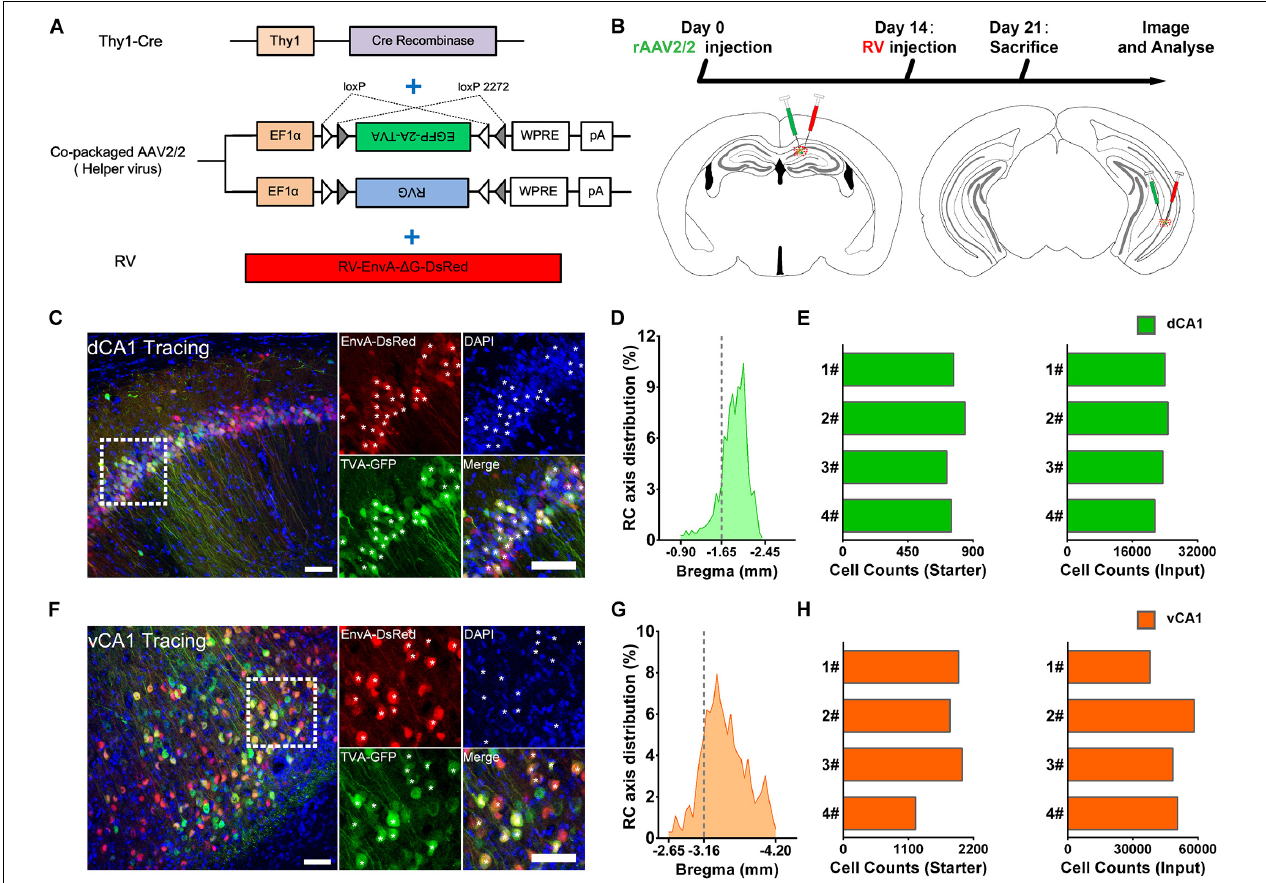
FIGURE 1 | Experimental procedures for the cell-type-specific retrograde monosynaptic tracing of dorsal CA1 or ventral CA1 PNs. (A) Thy1-Cre transgenic mice treated with co-packaged recombinant adeno-associated virus (AAV) strains and rabies virus (RV). (B) Experimental design showing timeline and injection site for dCA1 and vCA1 tracing group. (C,F) Representative images of coronal brain sections containing the injection sites and the magnifications of the starter cells ( C , the dorsal CA1 tracing group; (E) , the ventral CA1 tracing group). The starter cells coexpressing GFP and DsRed are indicated by white asterisks. Scale bar: 50 µ m. (D,G) Distribution patterns of the starter cells in the injected CA1 regions as detected along the RC axis. (E,H) Numbers of the starter cells and numbers of input neurons in whole brain in each mouse of dCA1 and vCA1 tracing groups (quantified with all slices; N = 4).